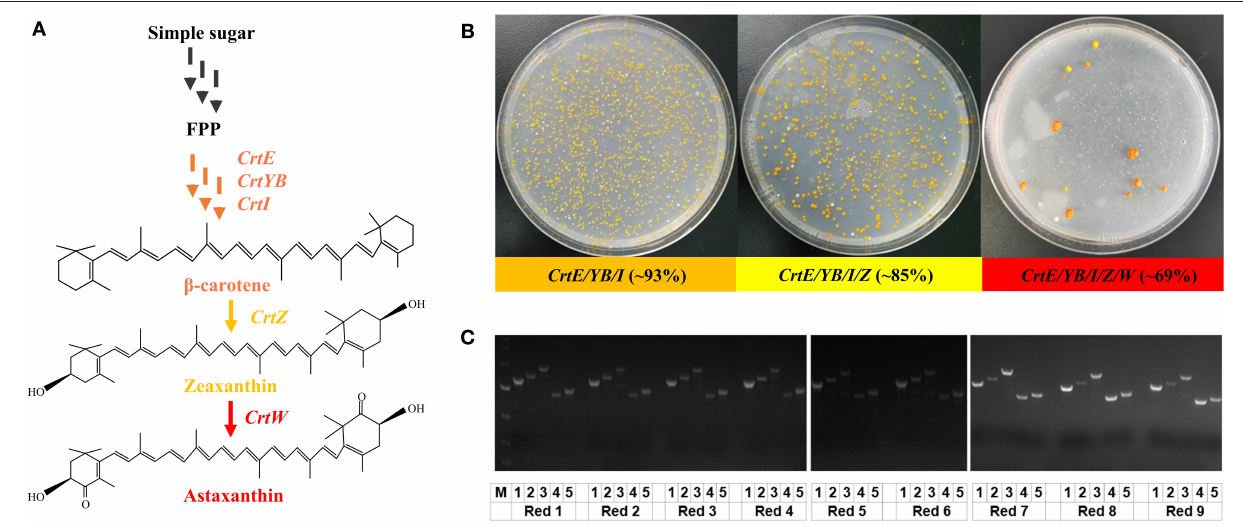
FIGURE 3 | “PCR & Go” system for the construction of yeast cell factories for β -carotene, zeaxanthin, and astaxanthin. (A) Overview of the carotenoid biosynthetic pathway. CrtE: geranylgeranyl diphosphate synthase; CrtYB: phytoene synthase/lycopene cyclase; CrtI: phytoene desaturase; CrtZ: β -carotene hydroxylase; CrtW: β -carotene ketolase. Multiple arrows indicate multiple reaction steps. (B) Integration efficiency of the three-gene, four-gene, and five-gene pathways using the “PCR & Go” system. 1.5 µ g of the PCR amplified gene fragments with 40 bp homology arms together with the corresponding gRNA plasmid(s) were co-transformed into the expression chassis and the integration efficiency was calculated based on both genotypic (diagnostic PCR) and phenotypic (pigment formation) results. The integration efficiency of the β -carotene pathway was calculated as the percentage of pigmented colonies (number of orange colonies/total number of colonies on the agar plate). The integration efficiency of the astaxanthin pathway was calculated as the number of colonies with correct PCR patterns for five genes/total number of colonies on the agar plate. (C) Genotyping of the nine colonies in red on the astaxanthin agar plate. Diagnostic PCR results for the yellow colonies and white colony were provided in Supplementary Figure 2 . 1, 2, 3, 4, 5 denoted CrtE , CrtI , CrtYB , CrtW , and CrtZ integrated into the expression chassis,